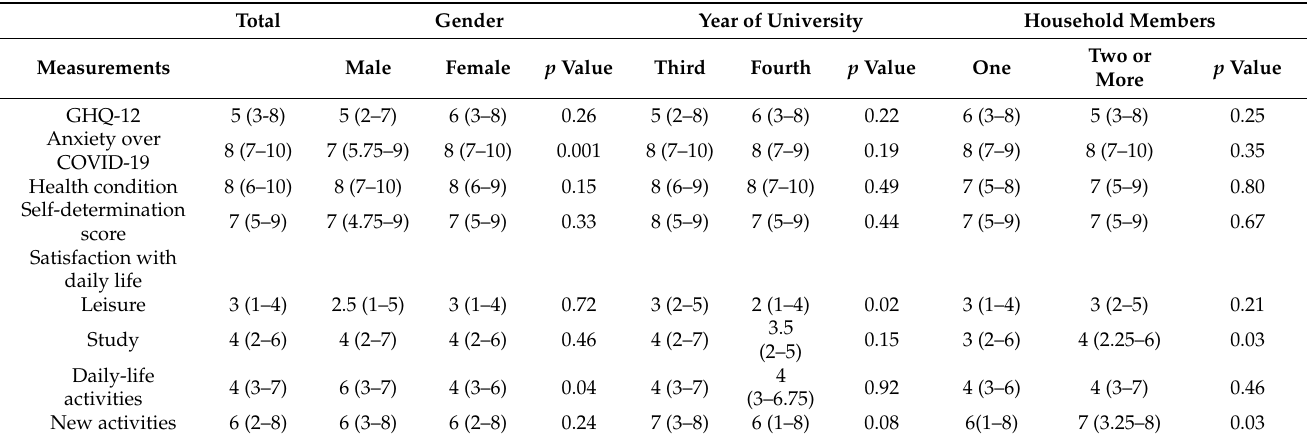
Table 2. Survey responses of the study